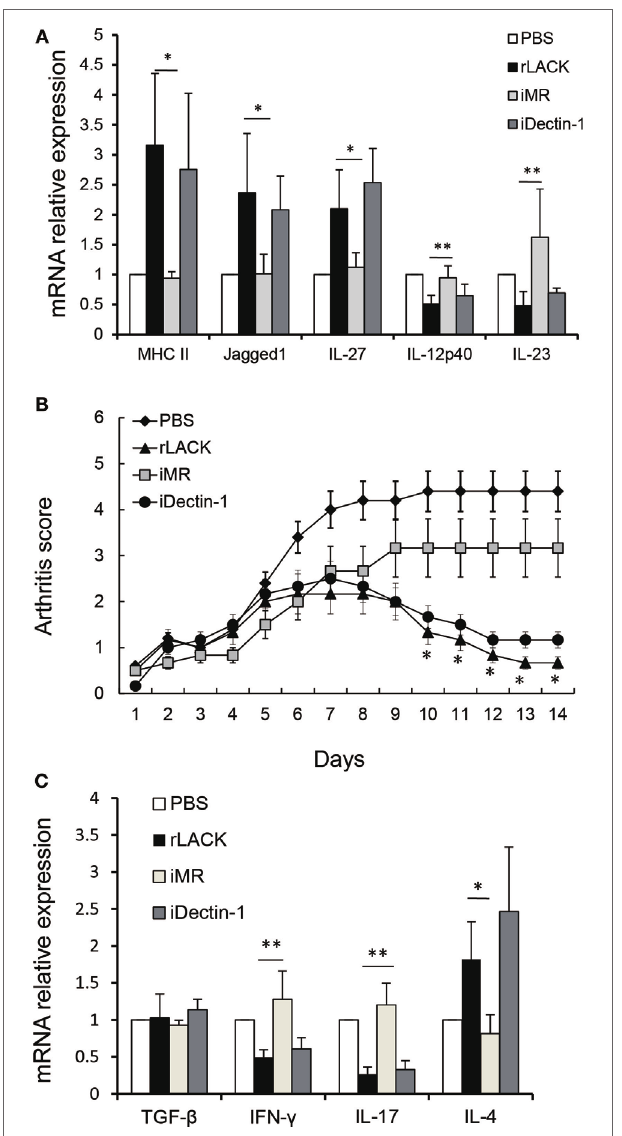
FigUre 7 | The effect of anti-mannose receptor (MR) on LACK 156–173 epitope-stimulated dendritic cells (DCs) and rLACK-treated collagen antibody-induced arthritis (CAIA) mice. (a) Bone marrow-derived dendritic cells (BMDCs) obtained from BALB/c mice in 12-well plates were pre- incubated with medium containing the monoclonal antibodies (mAbs) against MR, dectin-1 (10 µg/ml) for 1 h. Next, the cells were treated with rLACK (100 µg/µl) for 24 h. The mRNA expression of cytokines and surface molecules of BMDCs were measured by quantitative real-time polymerase chain reaction. (B) The effect of targeting MR on the arthritis scores of CAIA mice treated with rLACK. The mAb against MR/Dectin-1 (100 µg) was injected i.p. on day 4. Eight animals in each group. (c) Cytokines gene expression in the knee synovium of CAIA mice at day 14. Data are expressed as the mean ± SEM for five animals in each group, combined from at least three independent experiments. * p < 0.05, ** p < 0.01.